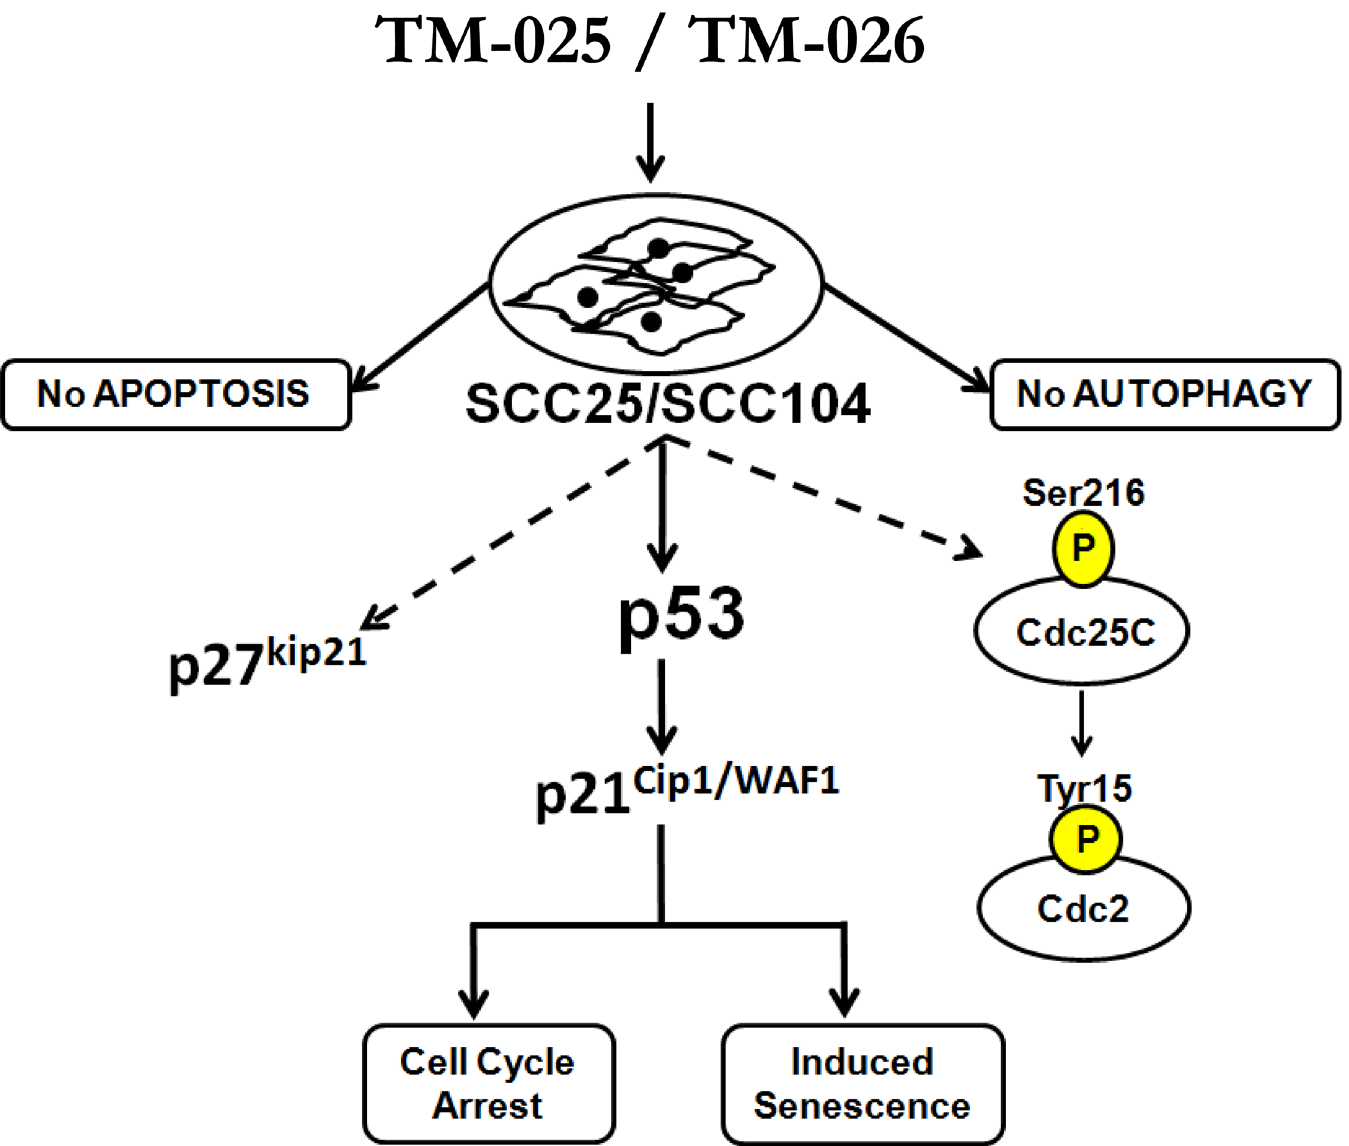
Fig 8. Schematic representation of mechanisms of action of the PCT analogs. Treatment of SCC25/SCC104 cells with TM-025 or TM-026 induced S- phase cell cycle arrest (S/G 2 -checkpoint) and senescence, but did not induce apoptosis or autophagy. At the molecular level, TM-025 and TM-026 induced expression of p53, its downstream target p21 Cip1/WAF1 , and also p27 kip21 , which are known to arrest cell cycle progression. Inhibition of p53 signaling by PFT abrogated TM-025/TM-026-induced S-phase arrest, thereby confirming a direct role of p53 in these processes. PCT analogs also enhanced phosphorylation of phosphatase Cdc25C (at Ser216 residue) and induced expression of total and Phsopho-Cdc2 (at Tyr15 residue). Inhibition of Cdc2 signaling by siRNA- mediated knockdown of Cdc2 did not relieve the drug-induced S-phase arrest. Solid arrows indicate confirmed mode of action of TM-025/TM-026 mediated via p53, while dotted arrows indicate additional downstream effectors of TM-025 and TM-026.